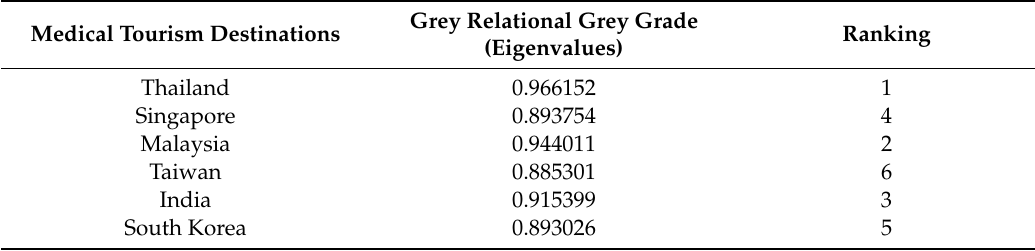
Table 4. Overall performance of six destinations of medical tourism in the Asia-Pacific region. Grey Relational Grey Grade Medical Tourism Destinations